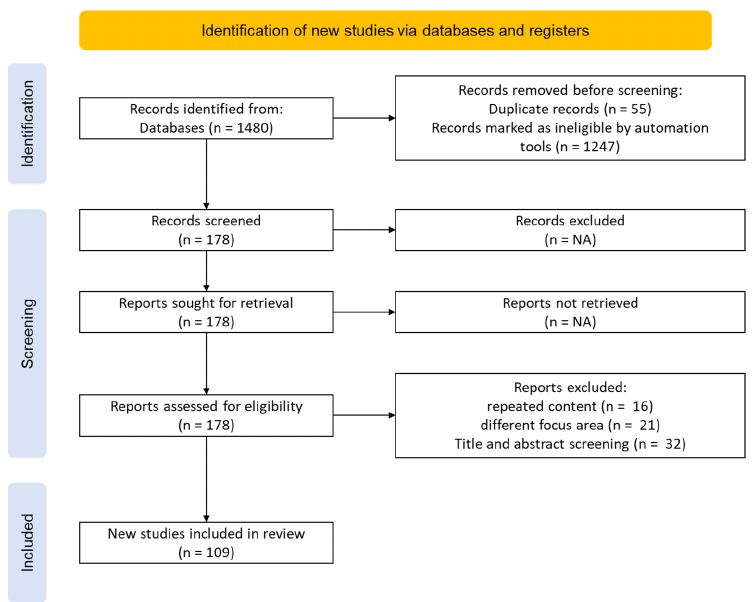
Figure 1. Identification, Screening, and Inclusion